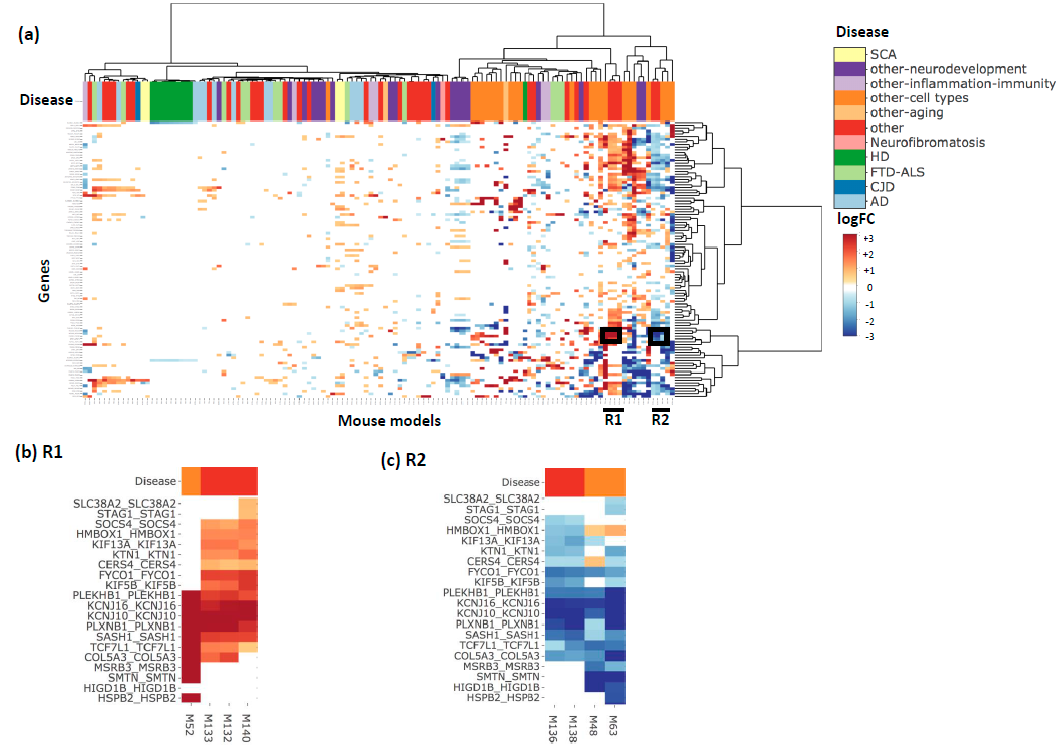
Figure 4. module 109 (m109) heatmap. ( a ) The heatmap of genes from module m109 from Mostafavi et al. [10] which was significantly associated with cognitive decline, annotated by disease. Each gene name is annotated as ‘Human-gene-symbol_Mouse-gene-symbol’. ( b ) A zoom in into the R1 boxed region from the heatmap where M132, M133, M140 study the effect of ethanol on synaptic transcriptome and synaptic plasticity. ( c ) A zoom in into the R2 boxed region from the heatmap where M48 studies the transcriptome in neurons while M63 studies the transcriptome of dopaminergic neurons from the midbrain.